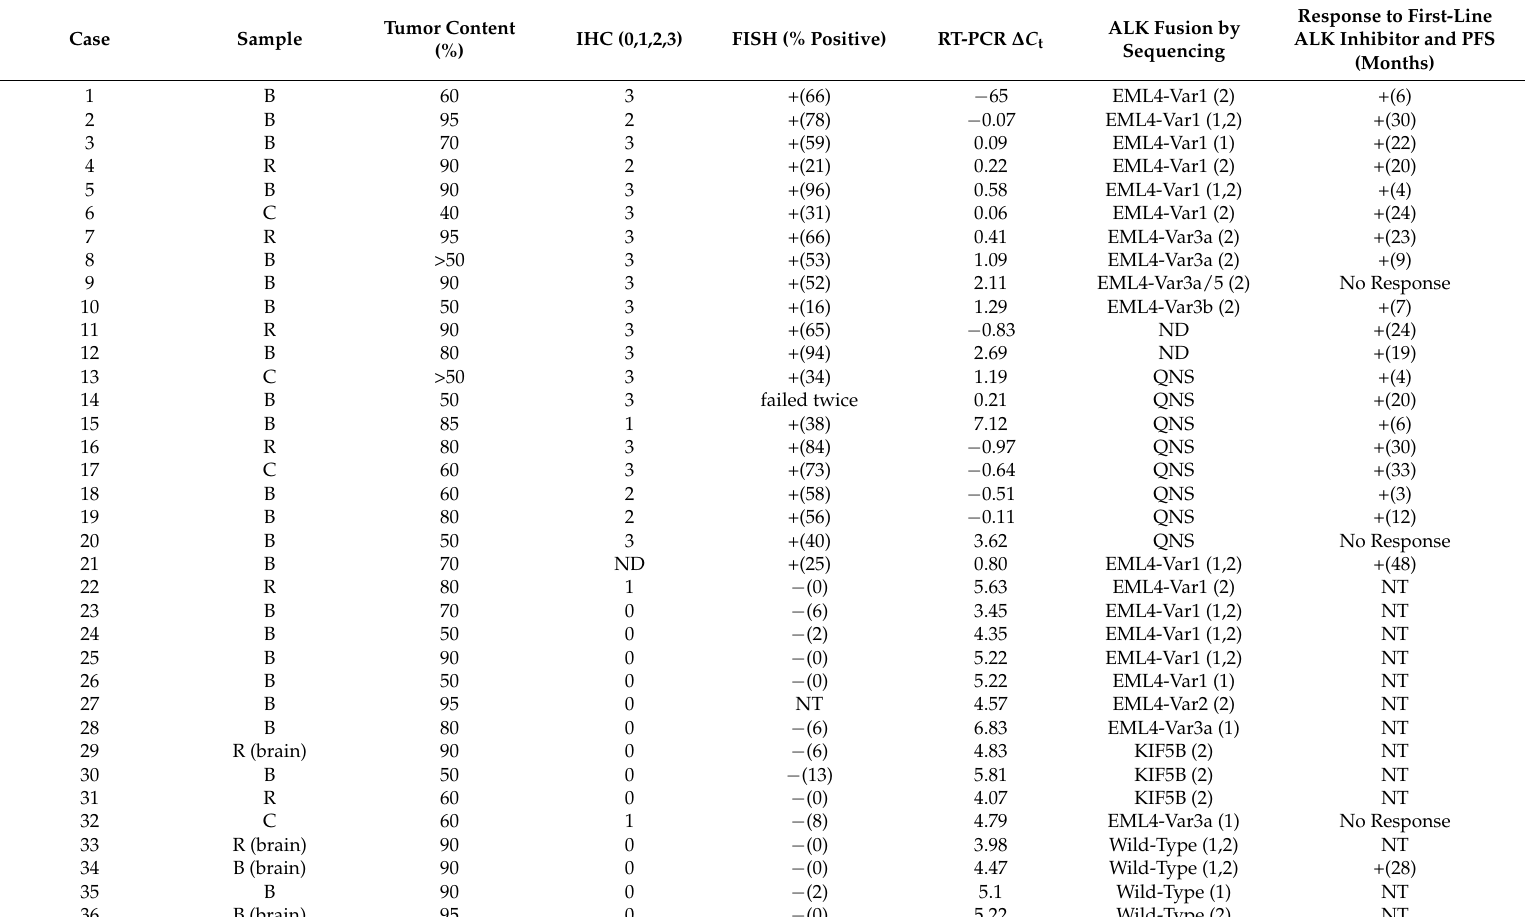
Table 2. Correlation of ALK immunohistochemistry (IHC) and fluorescence in situ hybridization (FISH) with RT-PCR-positive cases ( ∆ C t ≤